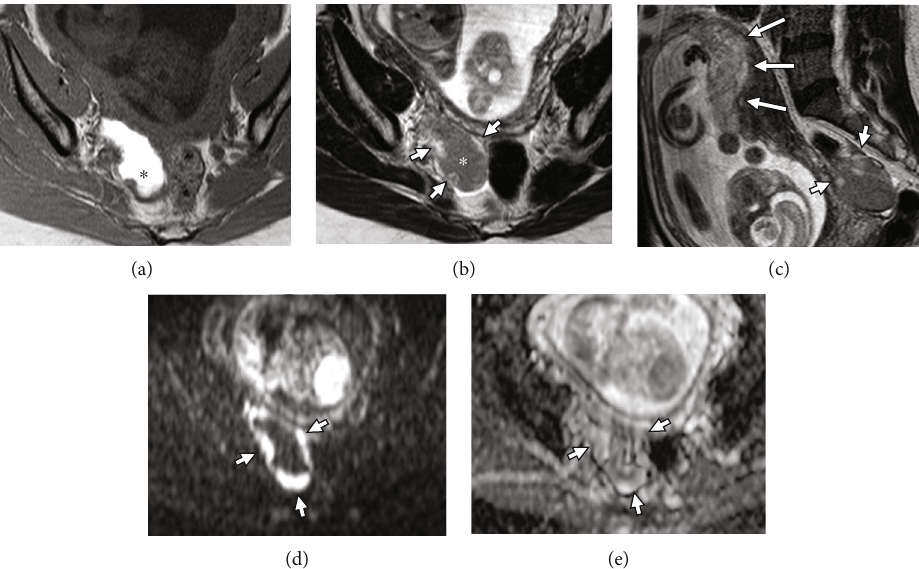
Figure 1: Magnetic resonance imaging (MRI) of the pelvis performed at 21 weeks of gestation. (a) Axial T1-weighted image. (b) Axial T2- weighted image. (c) Sagittal T2-weighted image. (d) Axial di ff usion-weighted image (b factor: 1000s/mm 2 ). (e) Apparent di ff usion coe ffi cient (ADC) map. MRI shows a well-circumscribed teardrop-shaped cystic lesion with mural nodules measuring 68 × 45 × 35mm in the right ovary. The cystic lesion shows uniformly marked high signal intensity on the T1-weighted image (a, asterisk) and intermediate signal intensity (b, asterisk) on T2-weighted images consistent with ovarian endometrioma. The mural nodules show intermediate to high signal intensity on T2-weighted images (b, c; short arrows) similar to the placenta (c, long arrows). Di ff usion- weighted image (d, short arrows) and ADC map (e, short arrows) show the mural nodules with a high ADC value ( 1 : 6 × 10 − 3 mm 2 /s ). Based on these imaging fi ndings, we diagnosed a decidualized ovarian